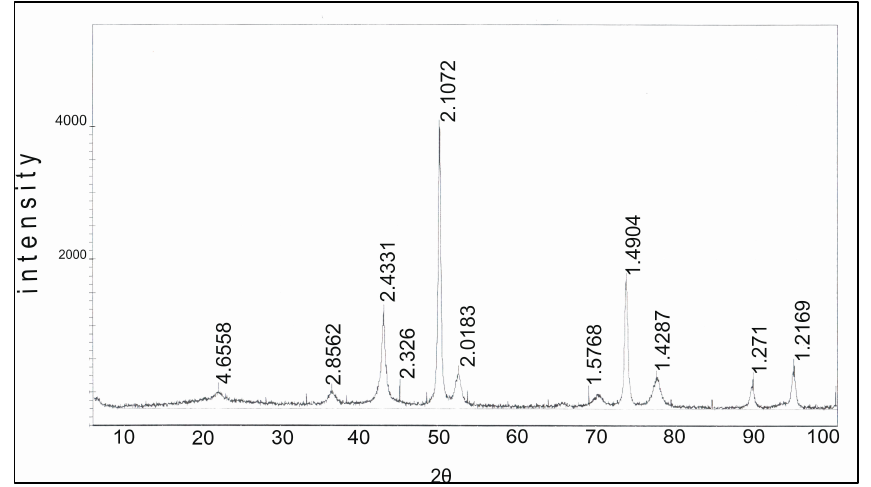
Figure 8. XRD patterns of 15% Co + 15% Mg/Al 2 O 3 calcined in air at 1100 ° С .